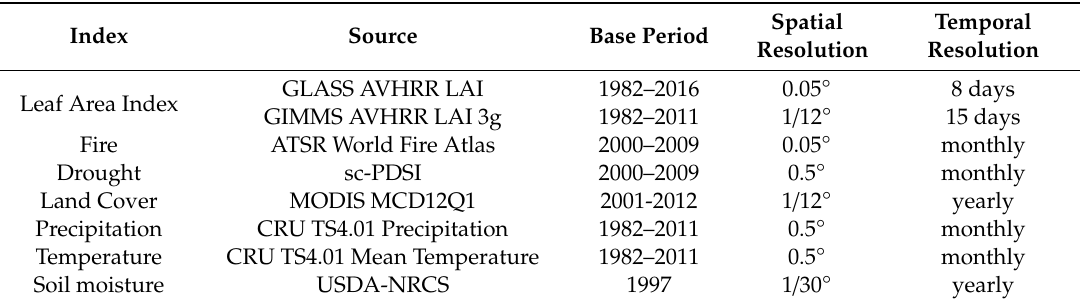
Table 1. Overview of data